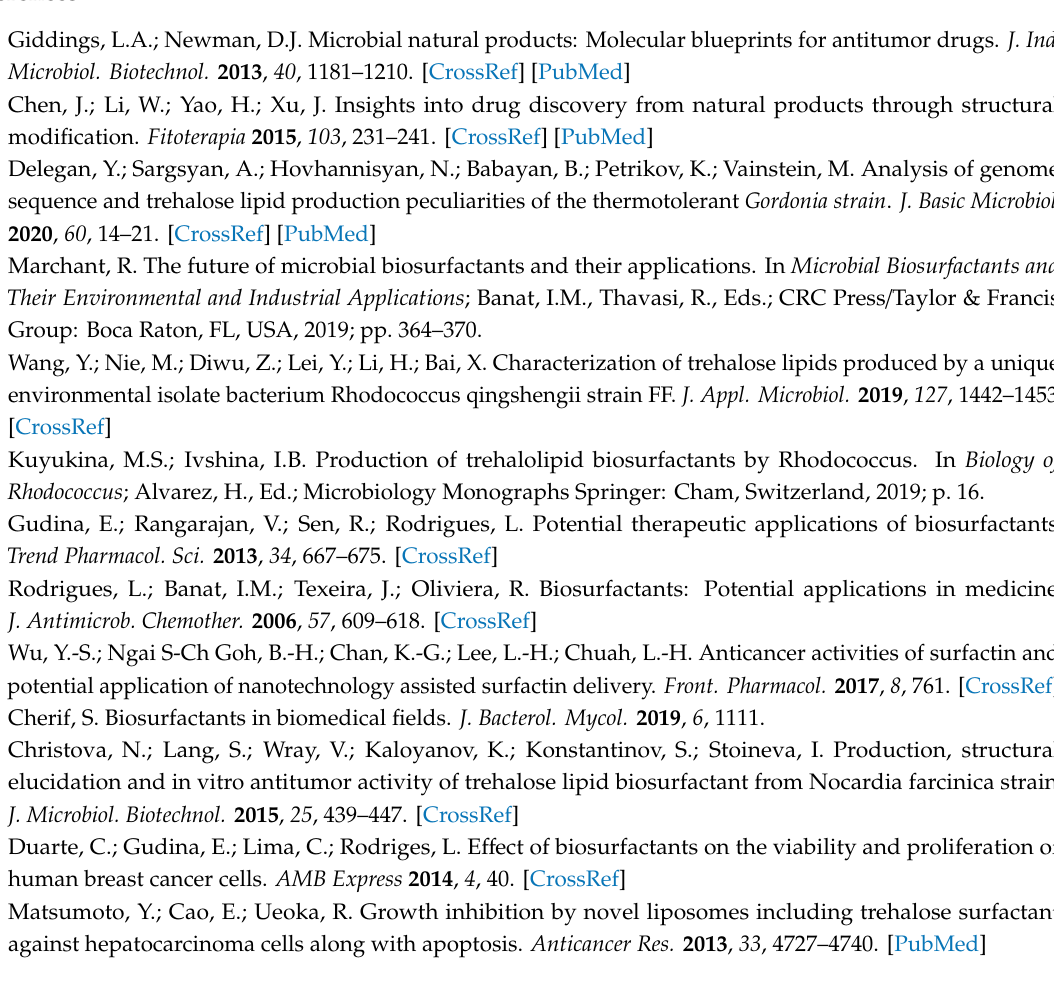
Figure S1: Figure S1. Changes in cell morphology of normal MCF10A cells / top panel / and cancer cells / MDA-MB231 cells – middle panel; MCF7 cells – bottom panel / 48 h after treatment with subcytotoxic concentration TL concentration (75 µ mol), analyzed by phase-contrast light microscopy. Untreated cells were used as a